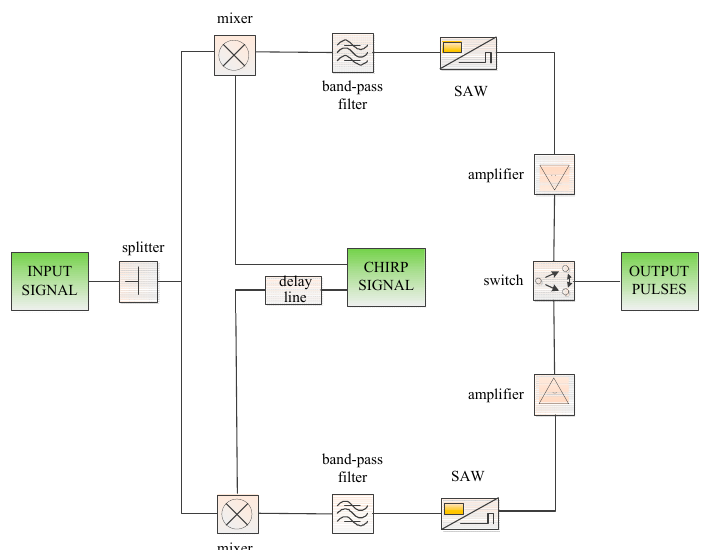
Figure 2. Simplified structure of the two-channel push-pull chirp transform spectrometer (CTS) system based on two M(l)-C(s) arrangements.